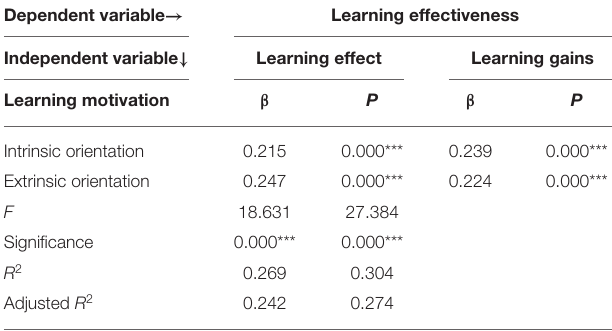
TABLE 3 | Analysis of learning motivation and learning